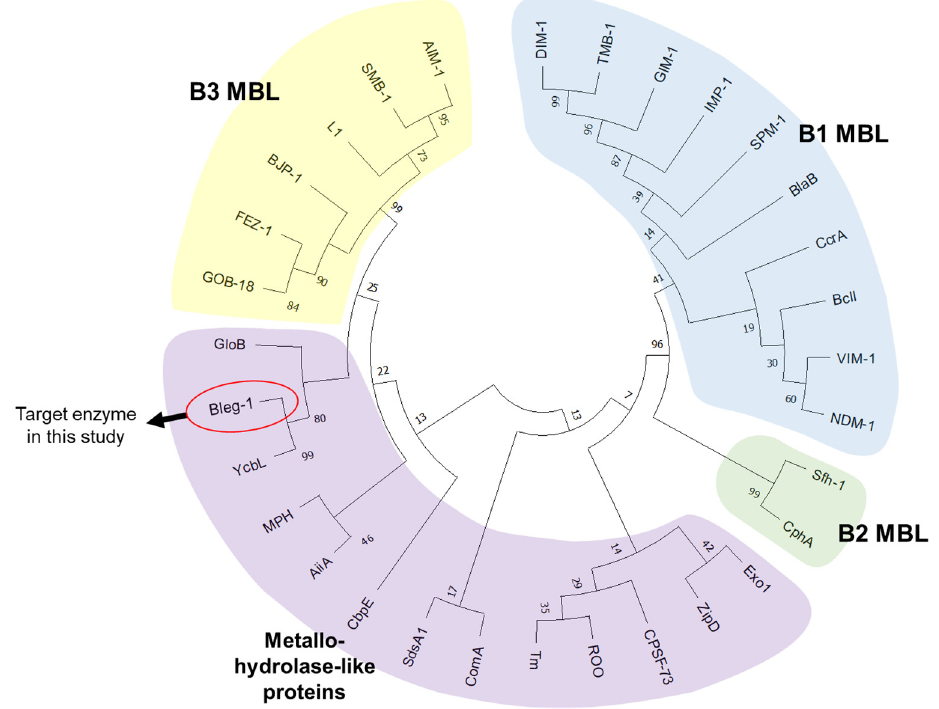
Figure 2. Phylogenetic tree of BLEG-1 with the representative enzymes from each family of the metallo-hydrolase-like MBL-fold protein superfamily, derived using neighbor-joining method. Bootstrap was performed with 100 replicates.